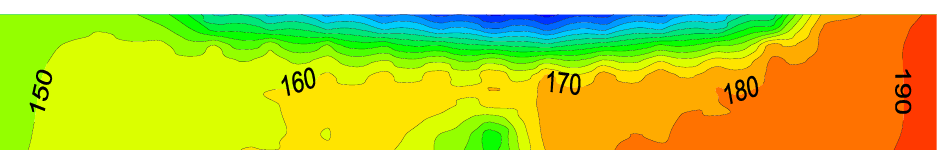
Figure 3. Temperature distribution of steam channeling between the two wells.